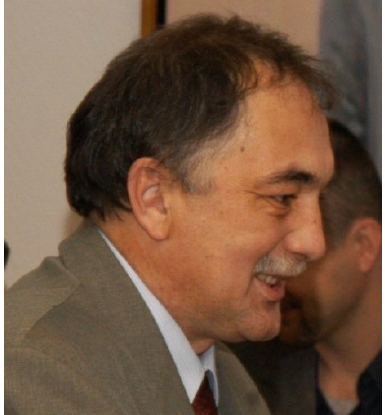
Figure 12. Ilgiz Irnazarow received his Ph.D. degree in Agricultural Sciences based upon